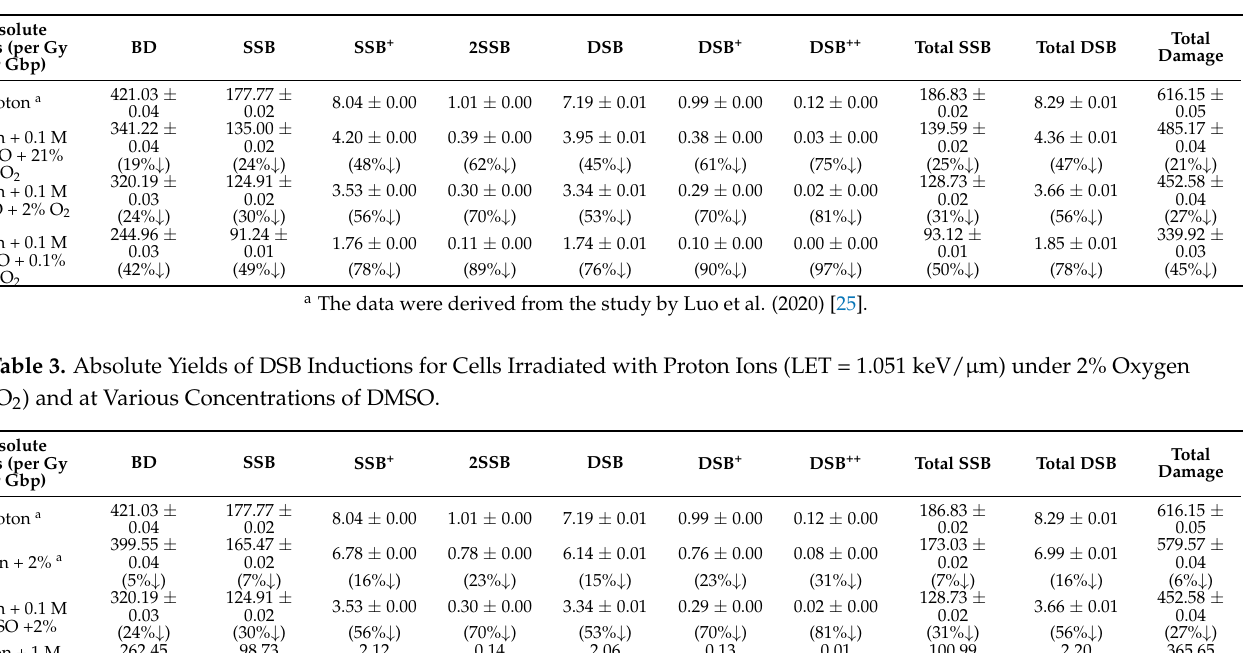
Table 2. Absolute Yields of DSB Inductions for Cells Irradiated with Proton Ions (LET = 1.051 keV/ µ m) under Various Concentrations of Oxygen (O 2 ) and at 0.1 M DMSO.